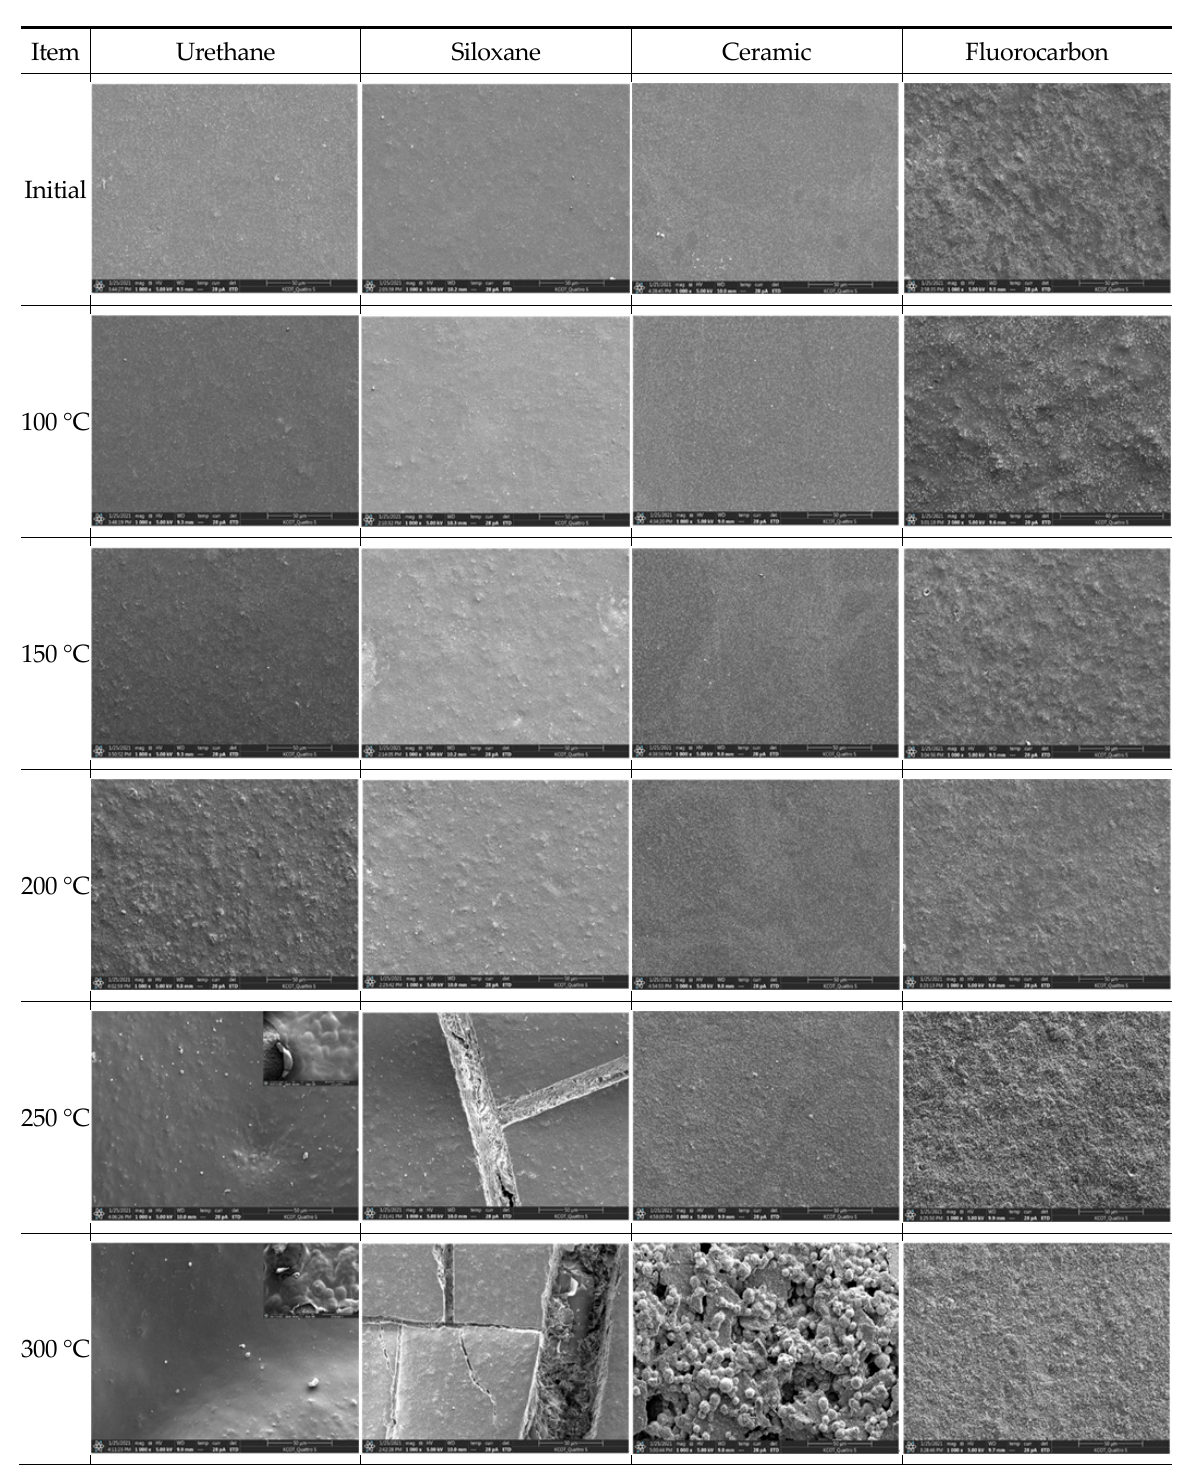
Figure 8. Magnified surface conditions (1000×).